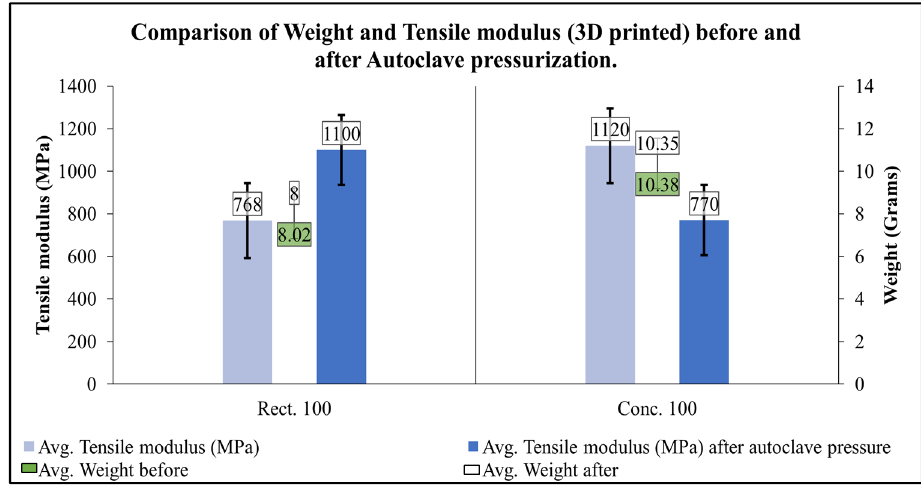
Figure 16. Showing comparison between weights and tensile modulus of PLA 3D-printed samples before and after autoclave pressurization.